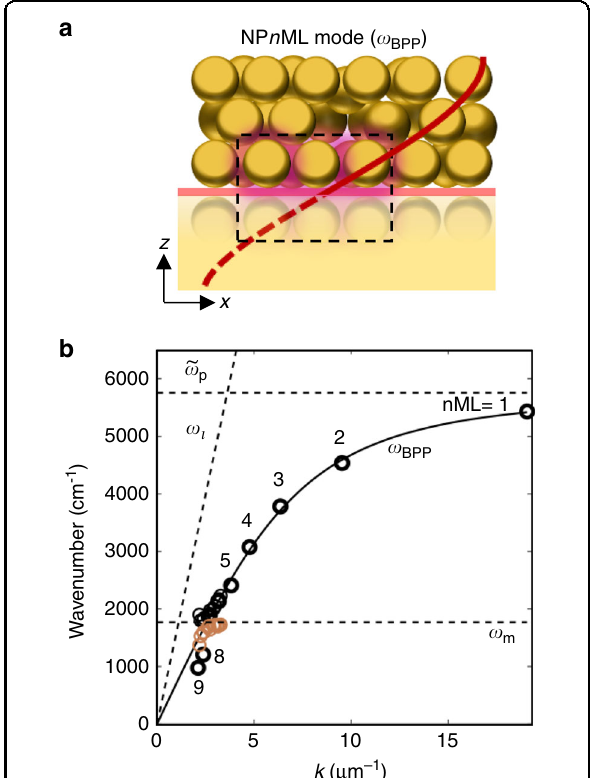
Fig. 2 Origin of infrared modes and fi eld localization. a Mode from layers of AuNP lattice-on-mirror (generating image dipoles). Red line depicts compression of IR λ from free space within the NP n ML-on- mirror, box indicates septamer-on-mirror motif. b Dispersion of NP n ML-on-mirror plasmon-polariton ω BPP (points — experimental data for n = 1 – 9 MLs) and fi t to Hop fi eld model (black line). Black and brown circles show additional anticrossing (Fig. 3) from coupling to CB[5] C = O stretch ( ω m ). Dashed lines show light-line inside uncoupled NP n ML-on-mirror ( ω l ) and bulk collective plasmon frequency ( e ω p